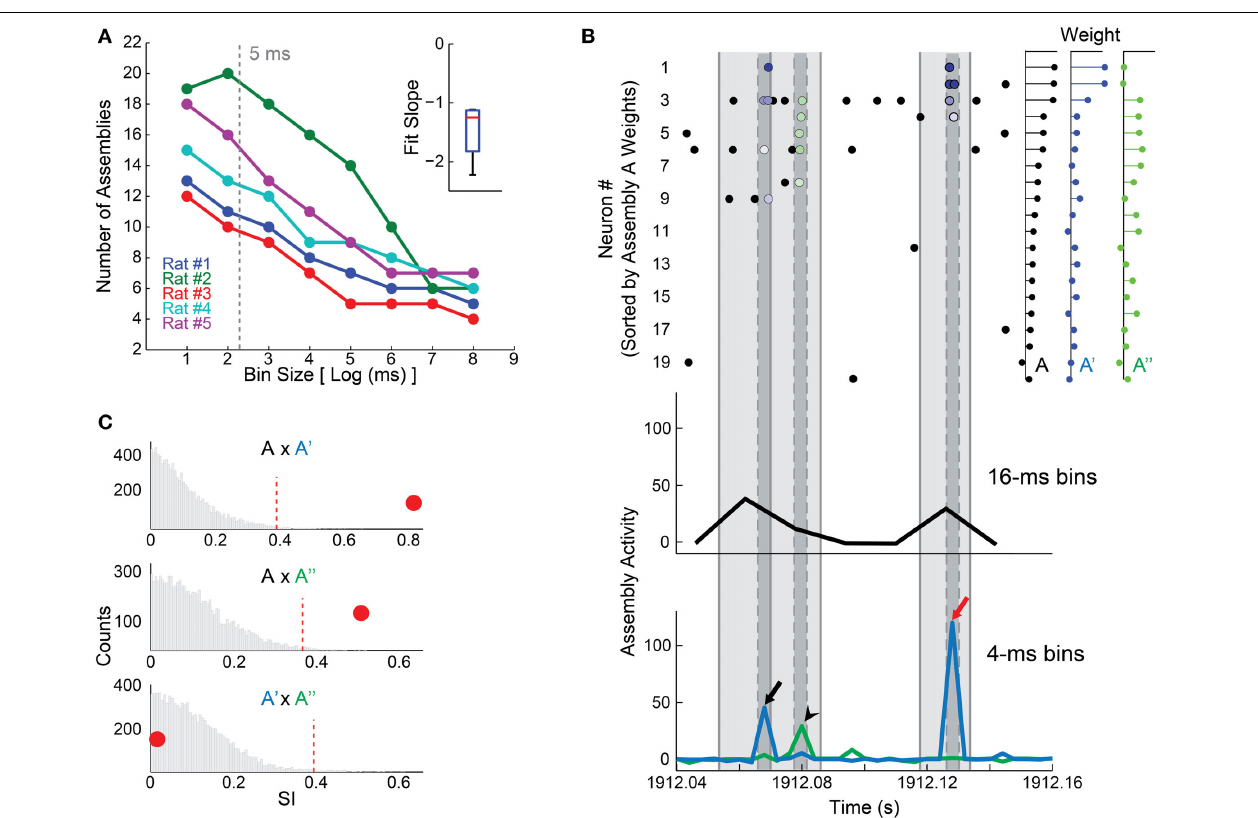
weight of the correspondent neuron in the assembly pattern. Note that neurons participating in assembly A (bin 16ms) were sorted into assemblies A (cid:2) and A (cid:2)(cid:2) (bin 4ms), which can be active in sequence (black arrow and arrow head) or independently (red arrow). (C) Exploring similarities between assemblies. Panels show the histogram of SI values from 10,000 comparisons made by shuffling the neurons weights within assemblies to build a null hypothesis (bootstrap procedure). Red dashed line shows the threshold for significance at p = 0 . 01. Red circles depict the SI between A and A (cid:2) (0.82, top), A and A (cid:2)(cid:2) (0.51, middle), and A (cid:2) and A (cid:2)(cid:2) (0.016, bottom). Note that assembly A is significantly similar to A (cid:2) and A (cid:2)(cid:2) ( SI = 0 . 82 and 0.51, respectively). The SI between A (cid:2) and A (cid:2)(cid:2) was small ( SI = 0 . 016), indicating that, in addition to the fact that these assemblies have independent activity, they also have orthogonal membership. A (cid:2) and A (cid:2)(cid:2) exhibit strong assembly activations at different time bins (panel B –arrows vs. arrow head). However, when 16ms time bins were used, the activities of these assemblies were packed in the same time window, causing the merge of A (cid:2) and A (cid:2)(cid:2) into